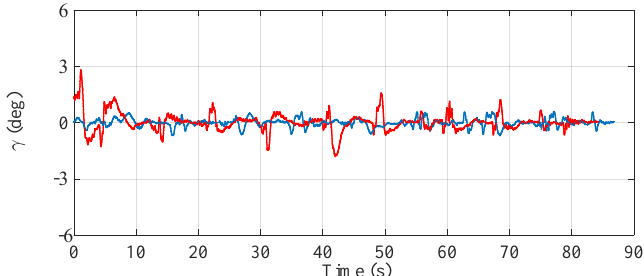
Figure 21. Inclination of the SCMS frame ( γ ) when the optimization is carried out with a α equal to zero ( — ) and when the optimization is not considered ( — ).